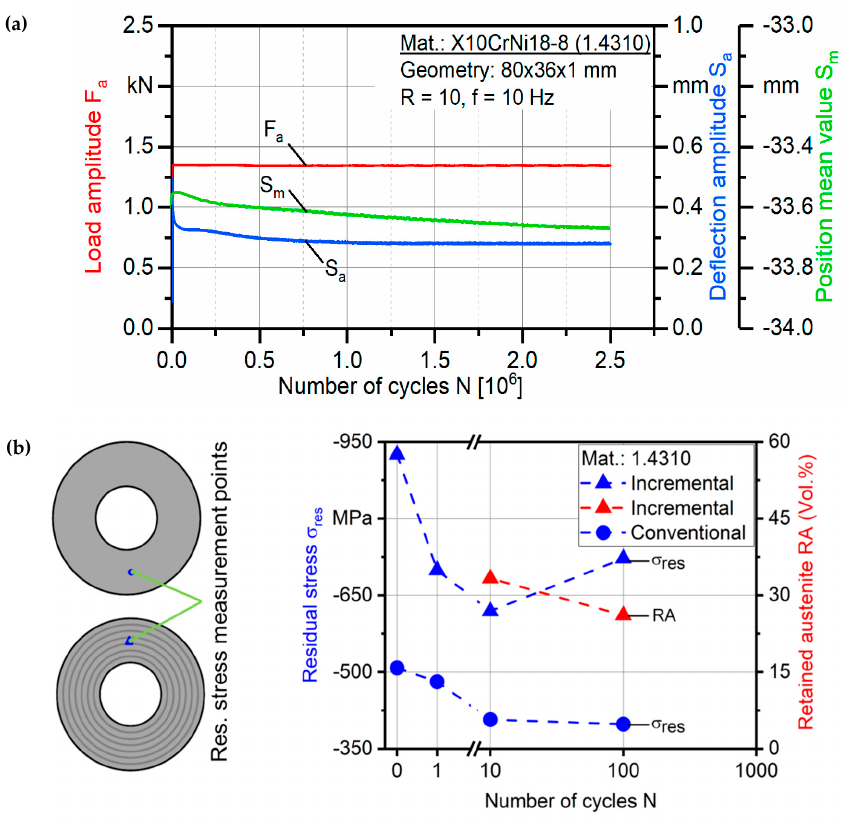
Figure 13. ( a ) Fatigue life investigation with a constant load amplitude for an incrementally formed disc spring of steel A. ( b ) Stability of the residual stresses in the first 100 loading cycles for steel A.